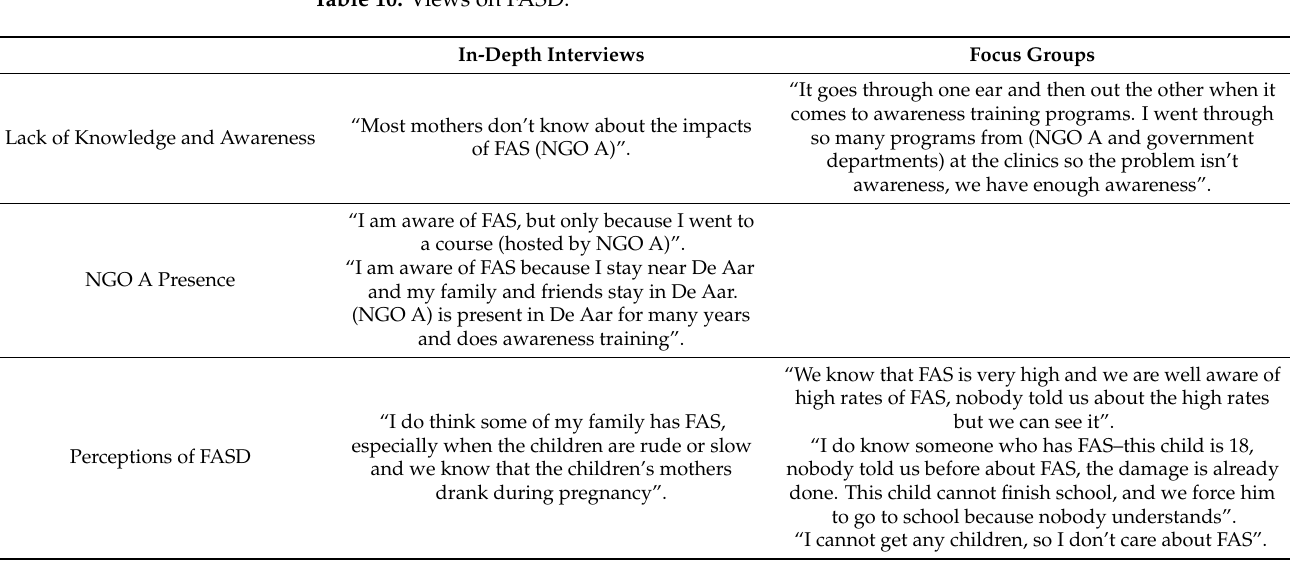
Table 10. Views on